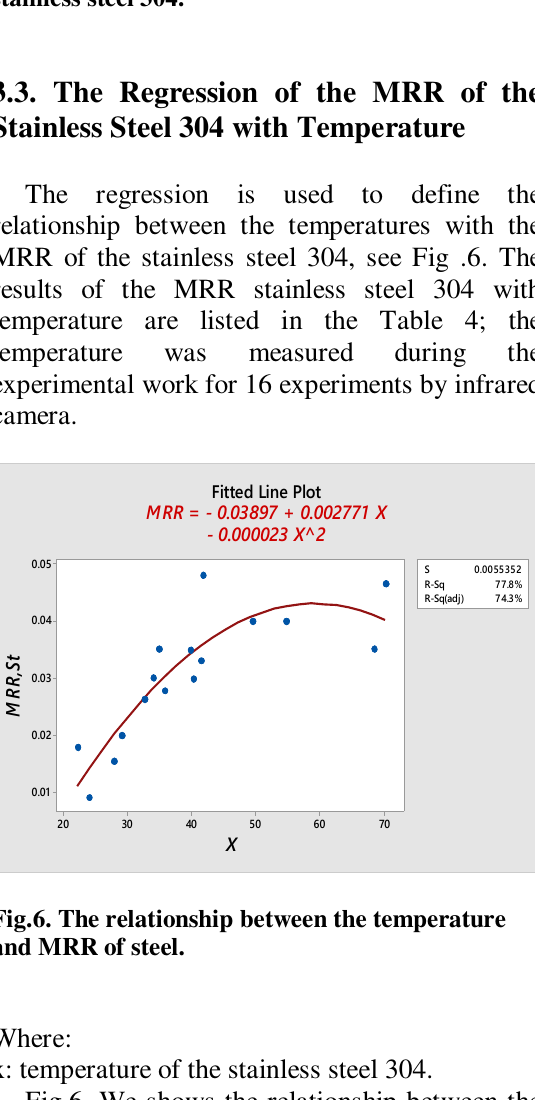
Fig. 5. Contribution of the parameters in the MRR stainless steel 304.